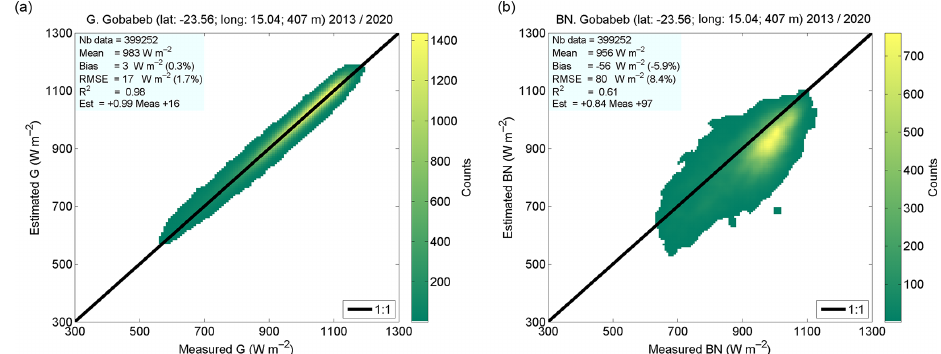
Figure 3. 2D histograms between measurements (horizontal axis) and McClear-v3 estimates (vertical axis) for G (a) and B N (b) at the BSRN station Gobabeb (no. 28). The color indicates the number of pairs in each